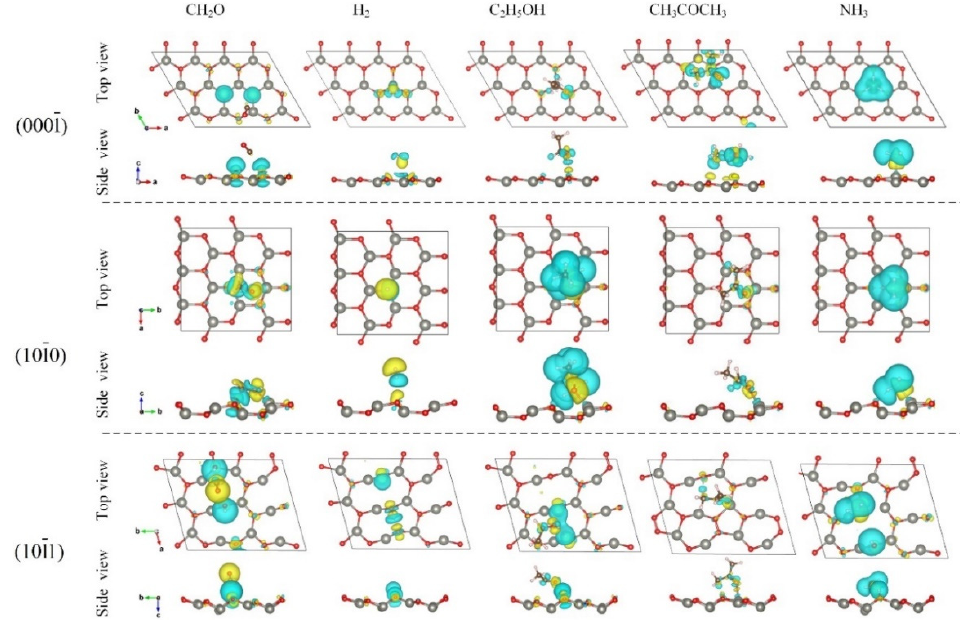
Figure 4. The charge density difference (CDD) of the adsorption systems. The blue and yellow isosurfaces are charge depletion and accumulation areas, respectively. The isosurface values are set to 0.0002 e/bohr 3 for H 2 / ZnO(0001) and H 2 / ZnO(1010) , 0.001 e/bohr 3 for CH 3 COCH 3 / ZnO(0001) and 0.005 e/bohr 3 for the other systems as the default value, respectively. For clarity, only the first bilayer is shown.